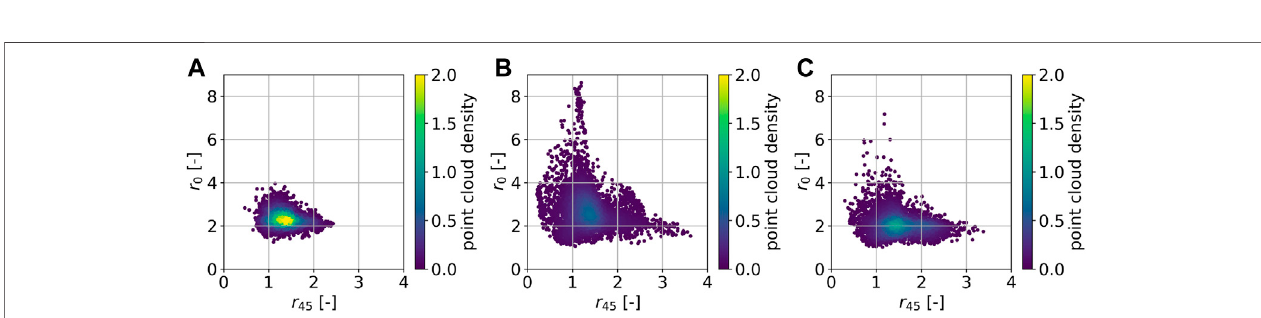
FIGURE 8 | 5,000 sampled texture-property data points projected into property space ( r 45 , r 0 ). The data points are generated on the basis of Latin hypercube design (A) , query-by-committee (B) and extended query-by-committee with r ≤ 5.0 (C) .